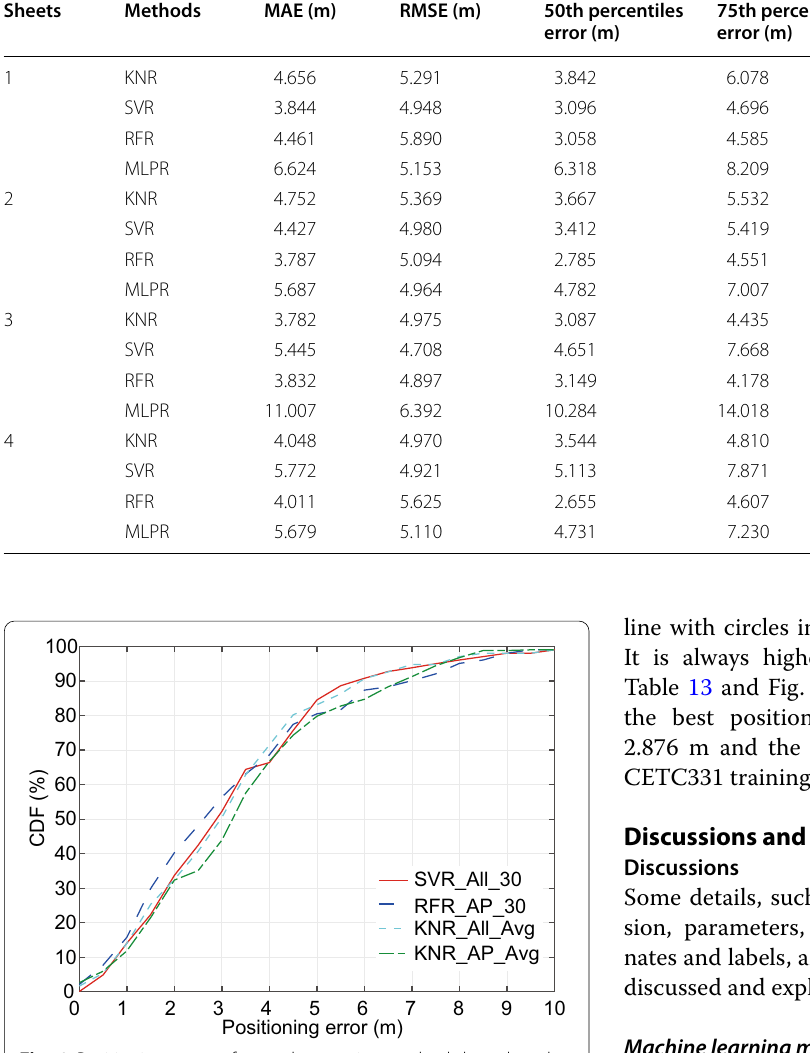
Table 12 Statistics of regression methods based on training sheets containing different MAC addresses and samples in the SYL building Sheets Methods